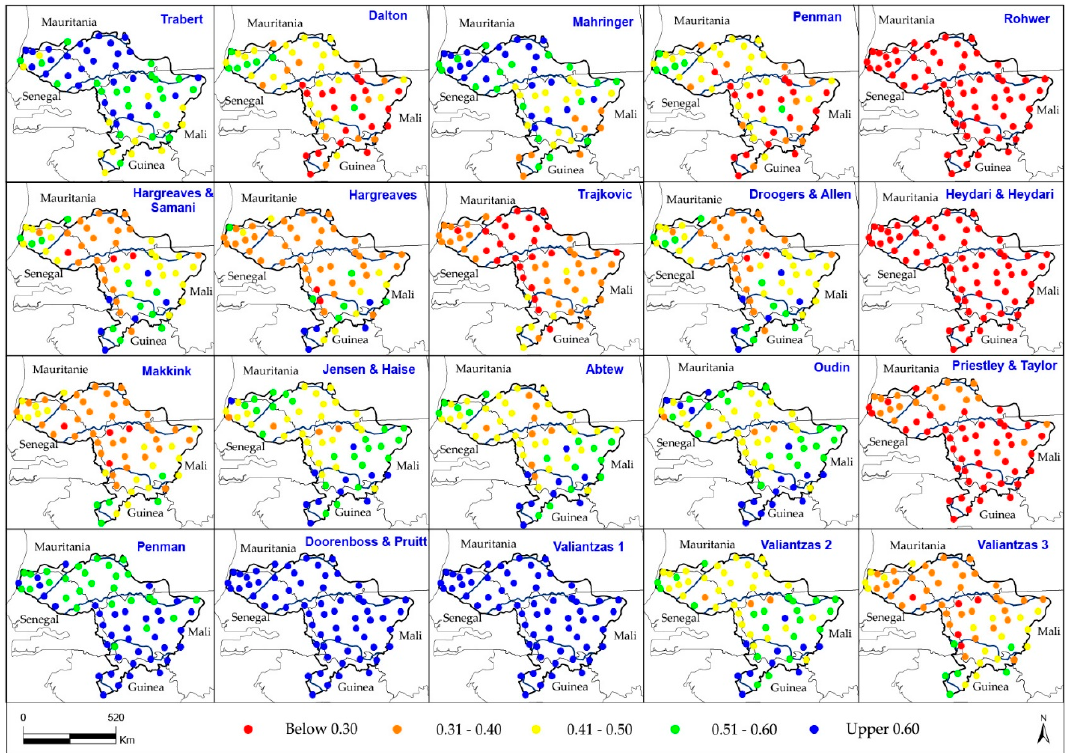
Figure 3. Spatial repartition of Kling–Gupta Efficiency (KGE) values.